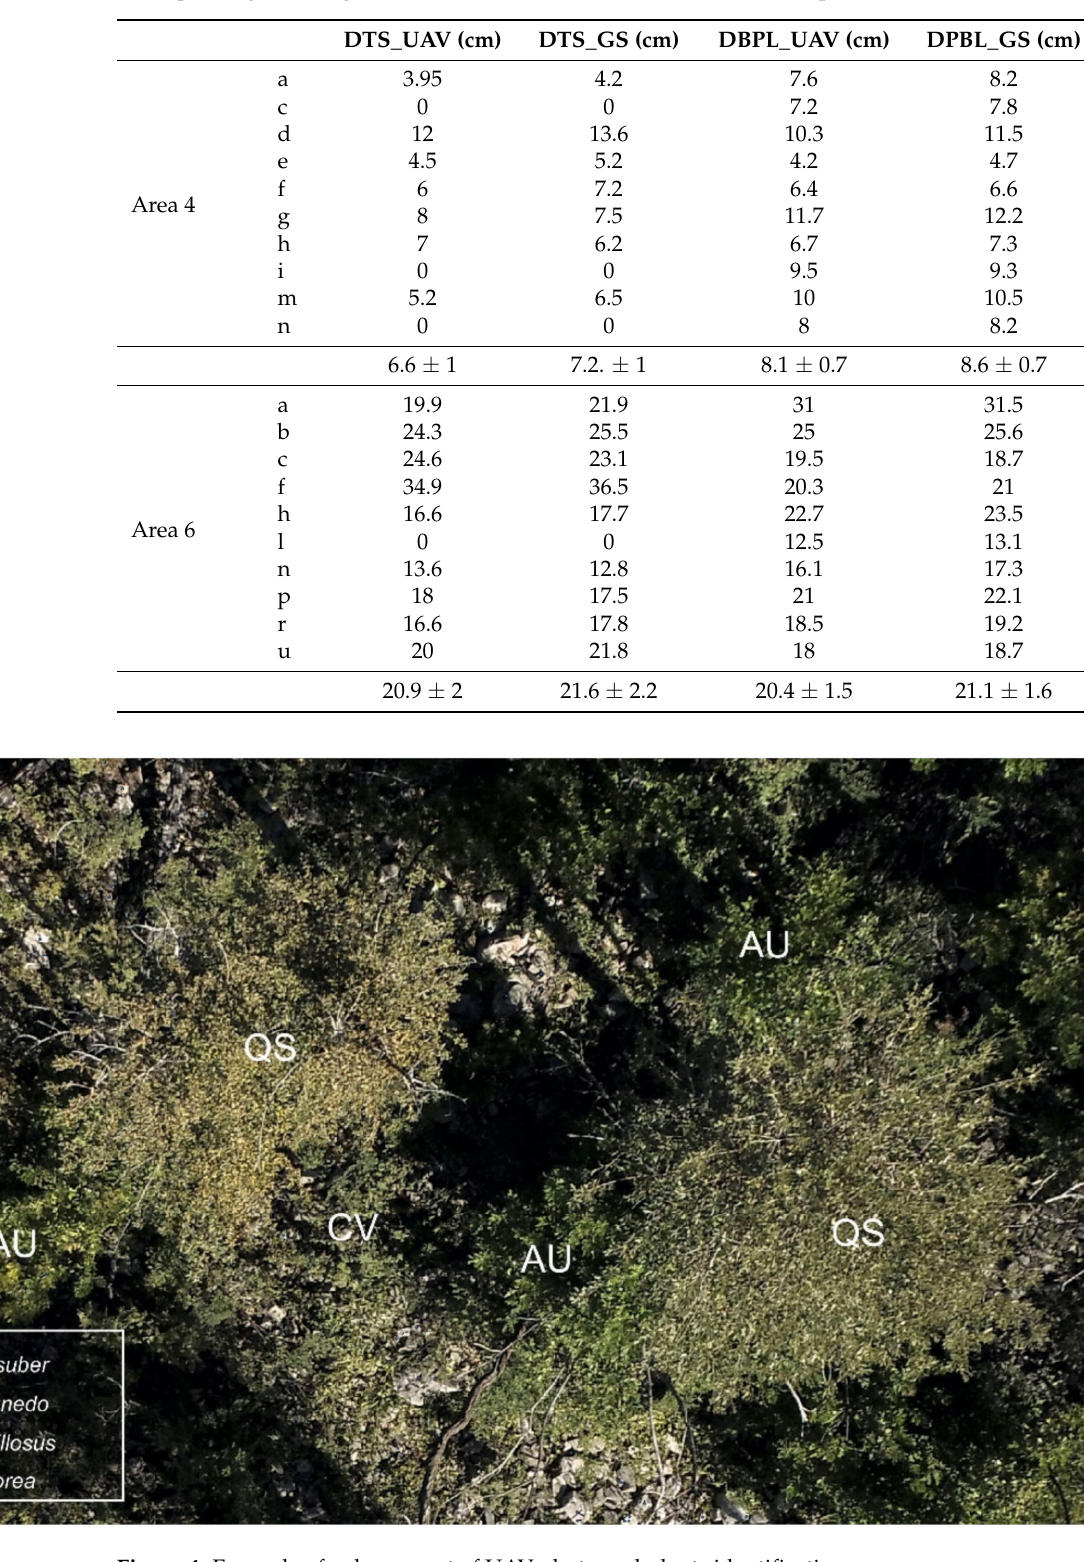
Figure 4. Example of enlargement of UAV photo and plants